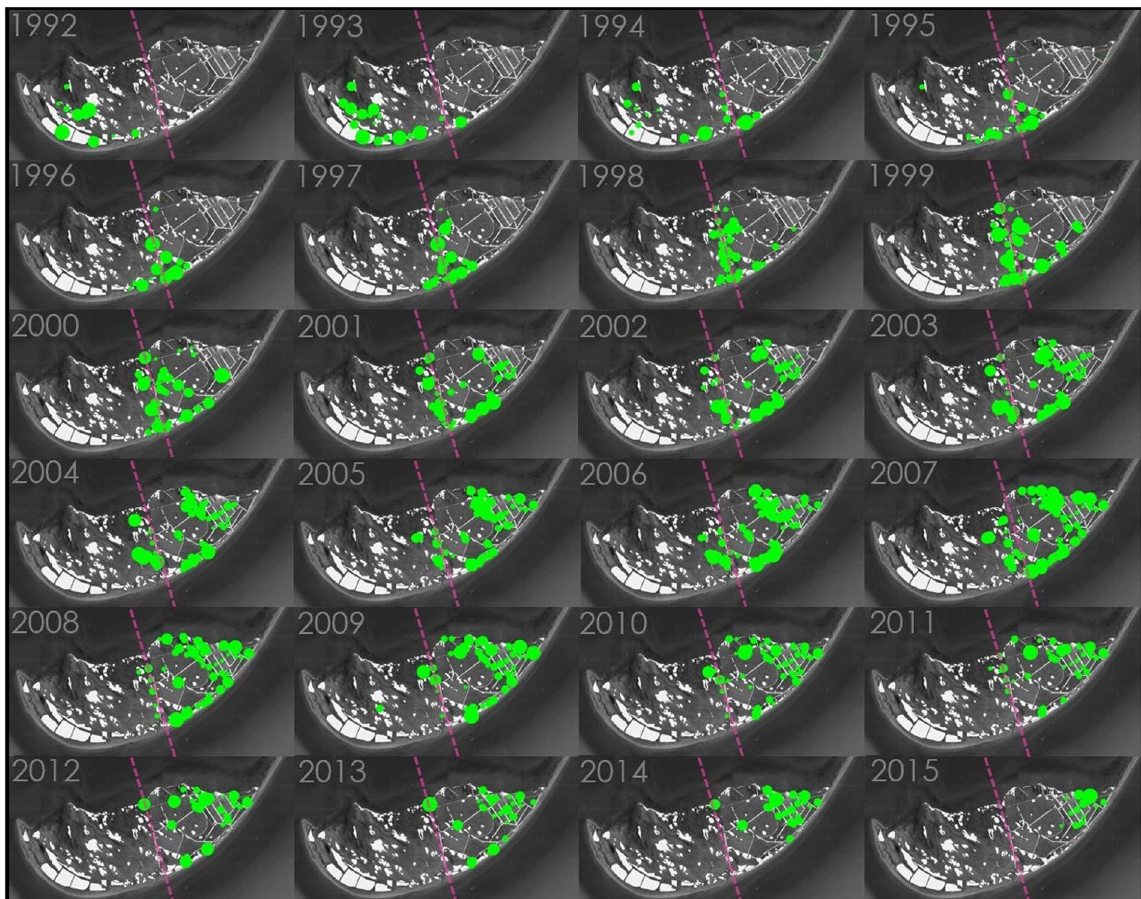
Figure 1. Spatiotemporal distribution of Audouin’s gull breeding patches at the Ebro Delta colony. White polygons represent the spatial distribution of potentially suitable breeding areas. Each annual image covers 60 km 2 . Green circles represent approximate locations of occupied patches and circle size is proportional to the number of individuals breeding in each patch. Predators were regularly present in the colony since 1997. Purple dashed lines represent the interphase between unmanaged dune vegetation (west) and human managed salt pans (east). Maps modified from: Google, 2016